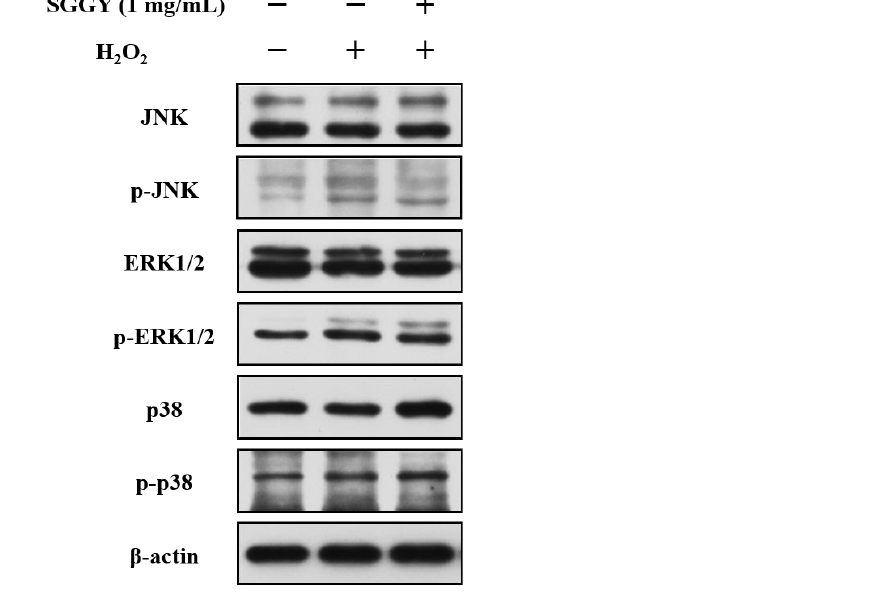
Figure 6. SGGY inhibited H 2 O 2 -triggered activation of the MAPKs signaling pathway in SH-SY5Y cells. Cells were pre-incubated with 1 mg/mL SGGY for 12 h and subsequently exposed to 900 µ M H 2 O 2 for 2 h. The expression of JNK, p-JNK, ERK1/2, p-ERK1/2, p38 and p-p38 were measured by Western